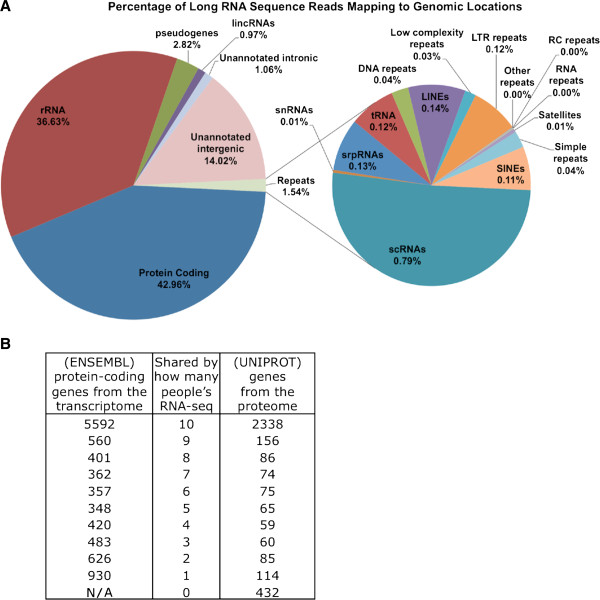
Reads, genes and the genome. A) Percentage of mapped reads across annotated genomic regions. Shown is the average percentage of uniquely mapped reads (long RNAs) that land on different genomic regions for the 10 samples. B) Table showing how many individuals share how many of the sequenced mRNAs (RNA-seq) and proteins (proteome reported in Burkhart et al [15]).